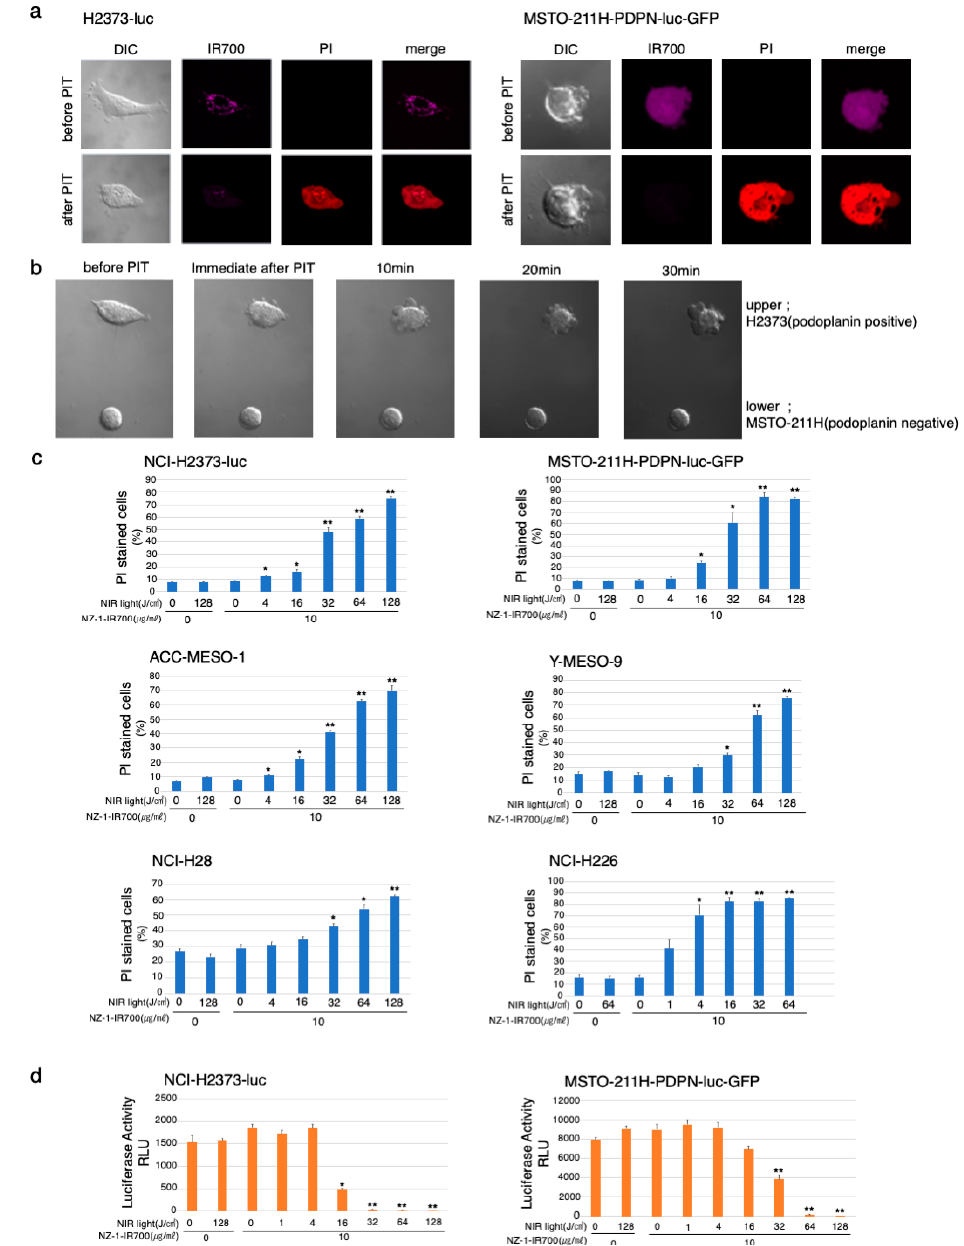
Figure 3. In vitro effects of NIR-PIT with NZ-1-IR700 on MPM cell lines. ( a ) Microscopic observations before and after PDPN-targeted NIR-PIT on H2373-luc and PDPN-overexpressing MSTO-211H cells with NIR-light (16 J/cm 2 ). ( b ) Co-cultured H2373 (PDPN positive) and MSTO-211H (PDPN negative) were used to assess the selective effect of NIR-PIT with NIR-light (16 J/cm 2 ). Only PDPN-expressing H2373 cells ruptured after the therapy. ( c ) Membrane damage induced by PDPN-targeted NIR-PIT was measured with the dead cell count using PI staining with flow cytometer which increased in a manner dependent on the light dose. Data are presented as means ± SEM ( n ≥ 4, * p < 0.05, ** p < 0.01, Student’s t -test). The cell death effect of PDPN-targeted NIR-PIT was universally demonstrated across the MPM cell lines. ( d ) Luciferase activity in H2373-luc and MSTO-211H-PDPN-luc-GFP cells was measured as relative light unit (RLU) which also decreased in an NIR-light dose-dependent manner. Data are presented as means ± SEM ( n ≥ 4, * p < 0.05, ** p < 0.01, Student’s t -test).